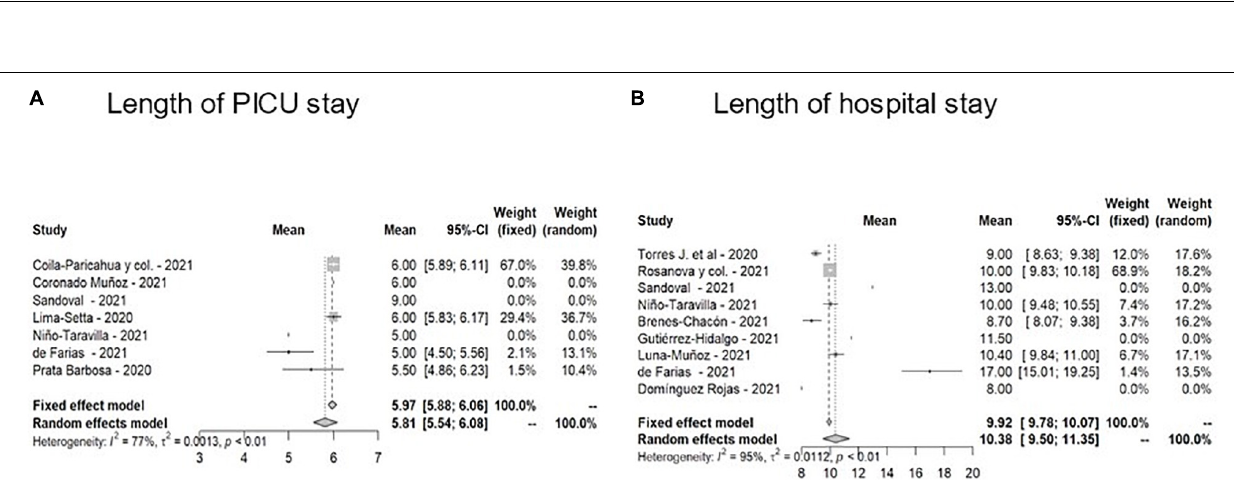
Frontiers in Pediatrics |